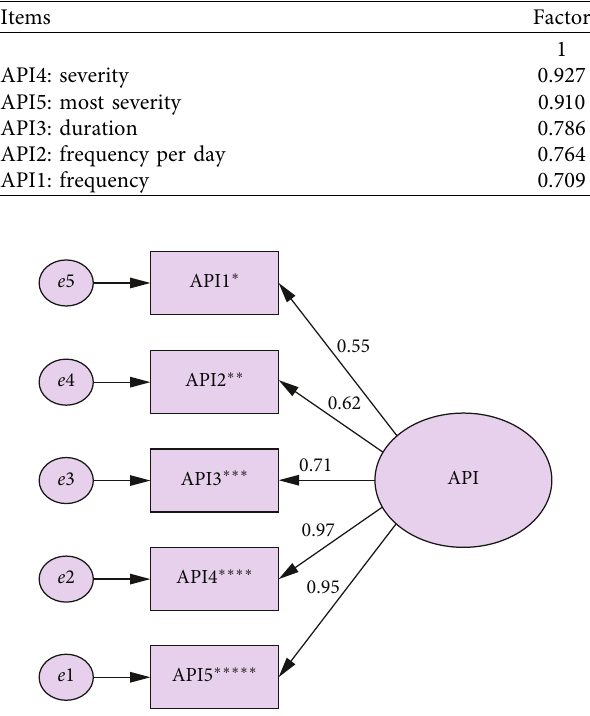
Figure 1: First-order confirmatory factor analysis with standardized coefficients. ∗ Frequency. Table 3: Confirmatory factor analysis and fit indices.